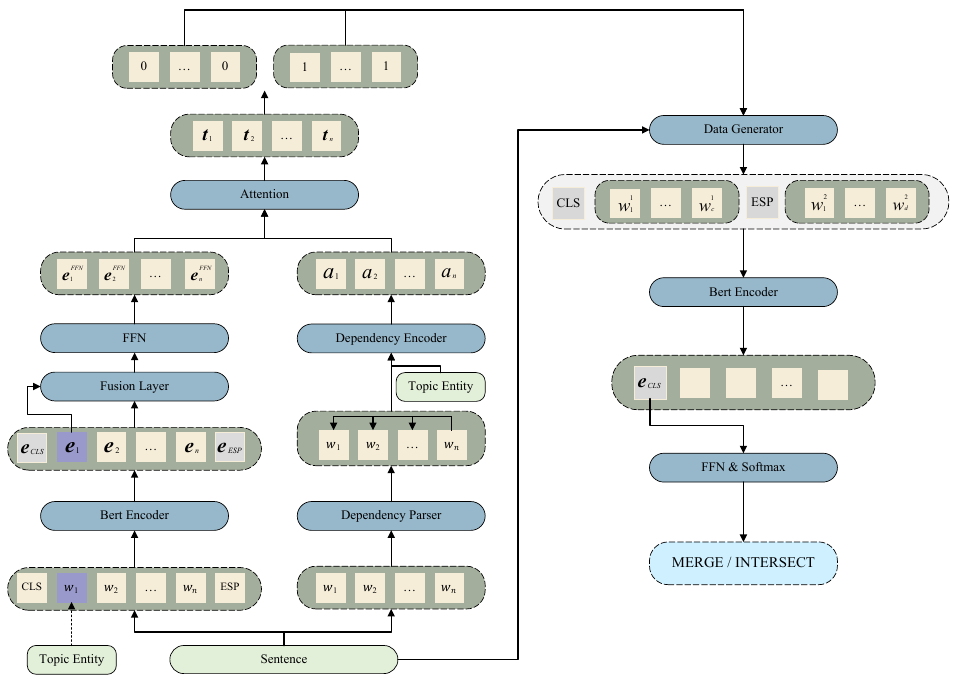
Figure 2. Complex question decomposition